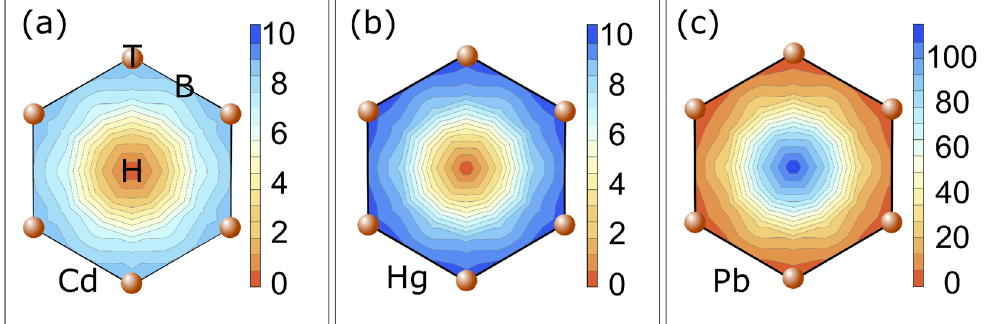
Figure 7. Total energy (in meV) as a function the ( a ) Cd, ( b ) Hg, and ( c ) Pb adatom position on a graphene hexagon, calculated for a 4 × 4 supercell. In all cases, the minimum total energy is set to 0 eV. Note the change in scale for ( c ).